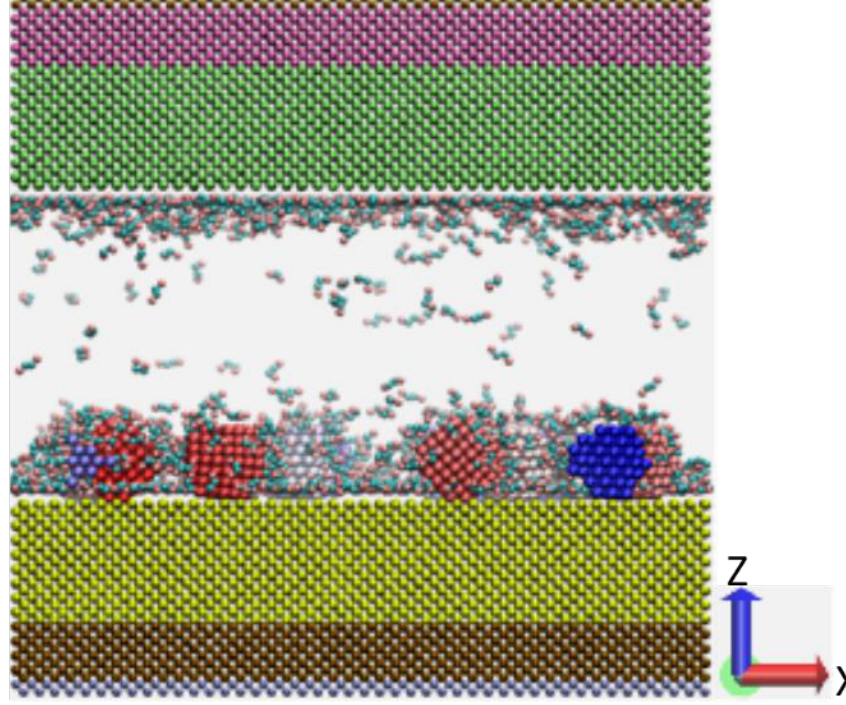
Figure 2. Lubricated model with 1500 C4-alkane molecules in the relaxation step.